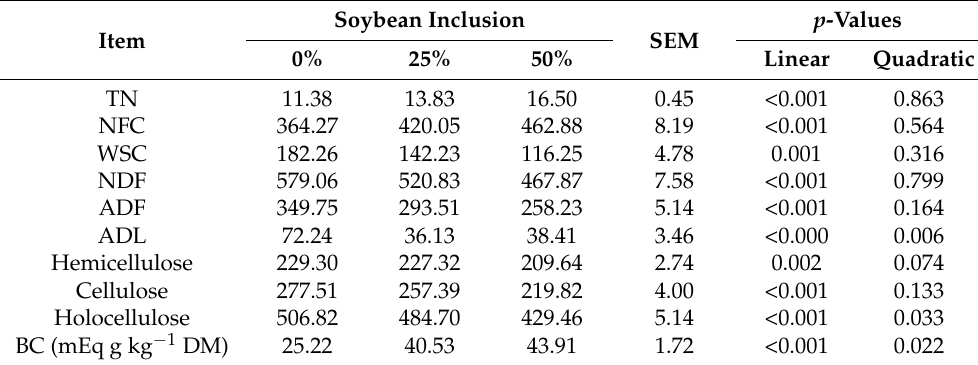
Table 1. Chemical characteristics of soybean incorporated sorghum forage before ensiling (g kg − 1 DM). Soybean Item